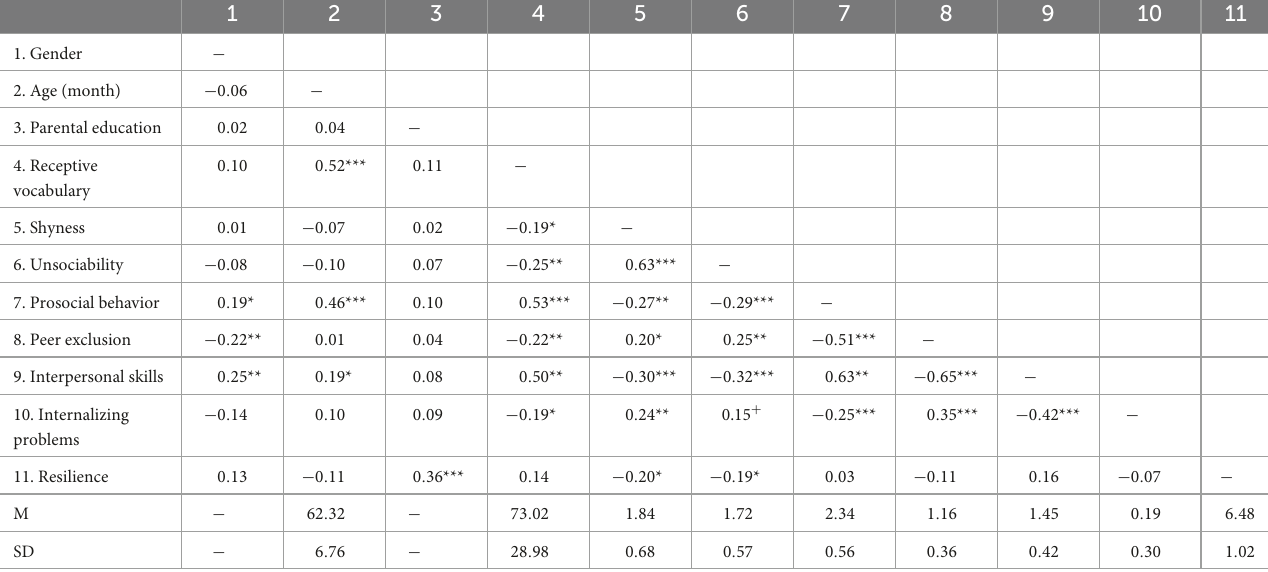
TABLE 1 Descriptive statistics and inter-correlations for all study variables ( N =